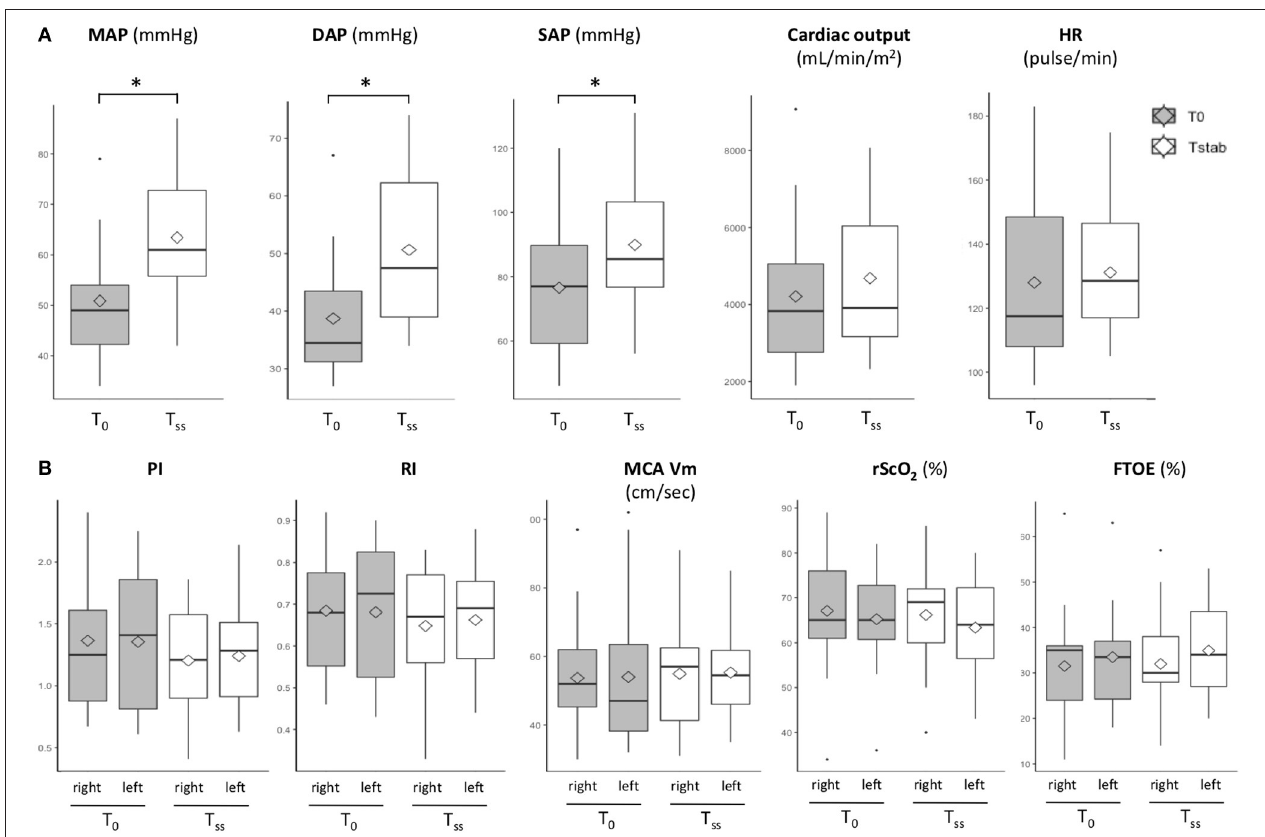
FIGURE 1 | Evolution of (A) systemic and (B) cerebral hemodynamics during norepinephrine infusion. The central bars and diamonds represent, respectively, the medians and means; the lower and upper ends of the box represent, respectively, the 1st and 3rd quartiles; the T-bars represent the 10th and 90th percentiles; circles are outliers; * p < 0.01. DAP, Diastolic Arterial Pressure; cFTOE, cerebral Fractional Tissue Oxygen Extraction; HR, Heart Rate; MAP, Mean Arterial Pressure; MCA, Middle Cerebral Artery; PI, Pulsatility Index; RI, Resistance Index; SAP, Systolic Arterial Pressure; T 0 , beginning of norepinephrine infusion; T ss , steady-state.